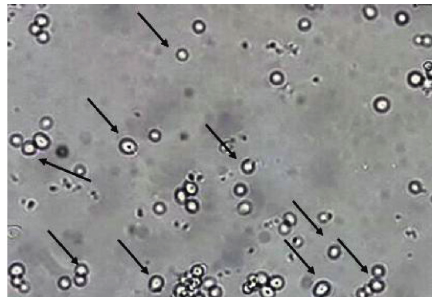
Figure 2: Appearance of Candida in a fresh